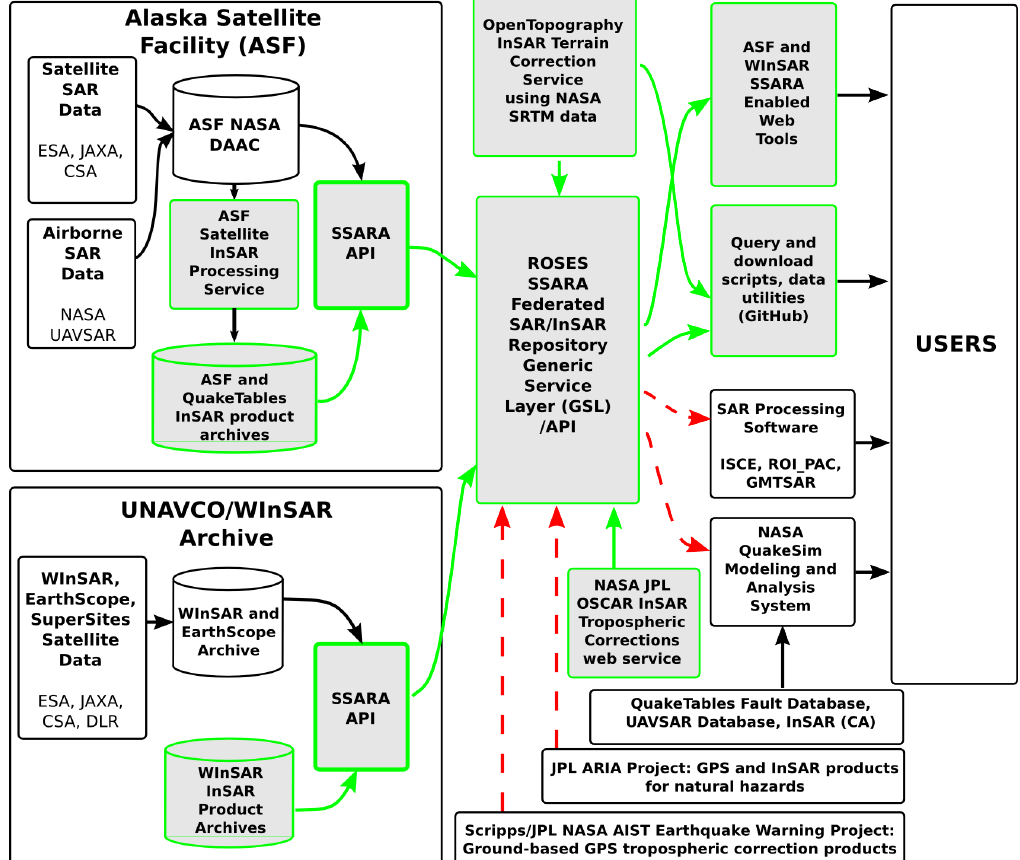
Figure 1. Diagram of SSARA workflow. Grey highlighted boxes show component development as part of the project, green outlines represent tasks already implemented and red outlines represent future